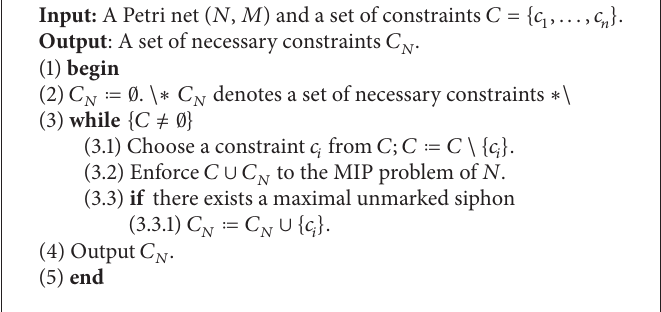
Algorithm 1 eliminates redundancy by excluding a con- straint each time. If the liveness is preserved after remov- ing the constraint, we can conclude that the constraint is redundant and should be removed. Otherwise, it should be considered as necessary.